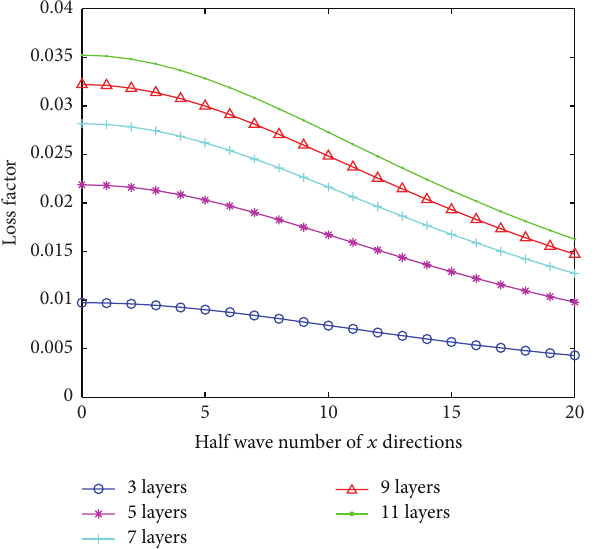
Figure 12: The loss factor of constrained damping plate with various layers ( 𝑛 = 20 ).